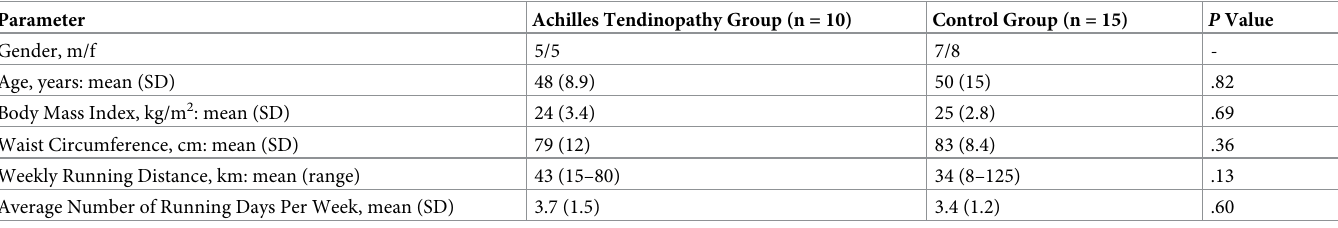
Table 1. Participant